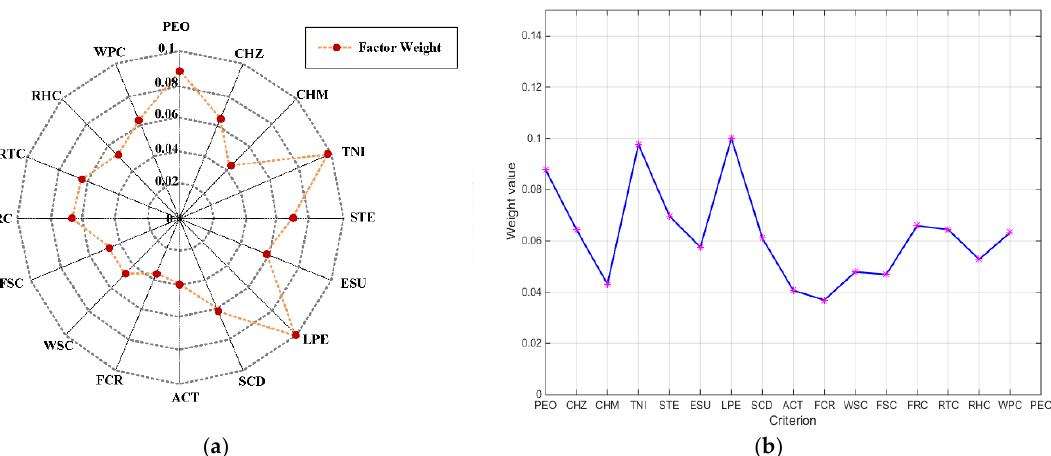
Figure 4. Weight of each sub-criterion for the case study: ( a ) the radar chart; and ( b ) weight value of each criterion.